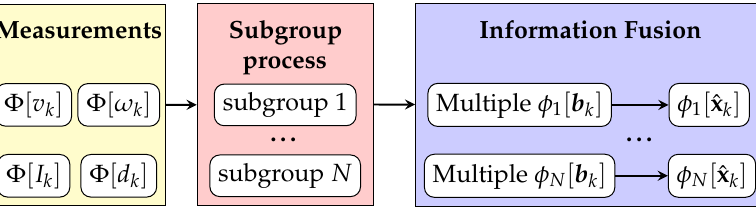
Figure 2. The pipeline of the proposed algorithm. The details of the subgroup localization process are shown in Figure